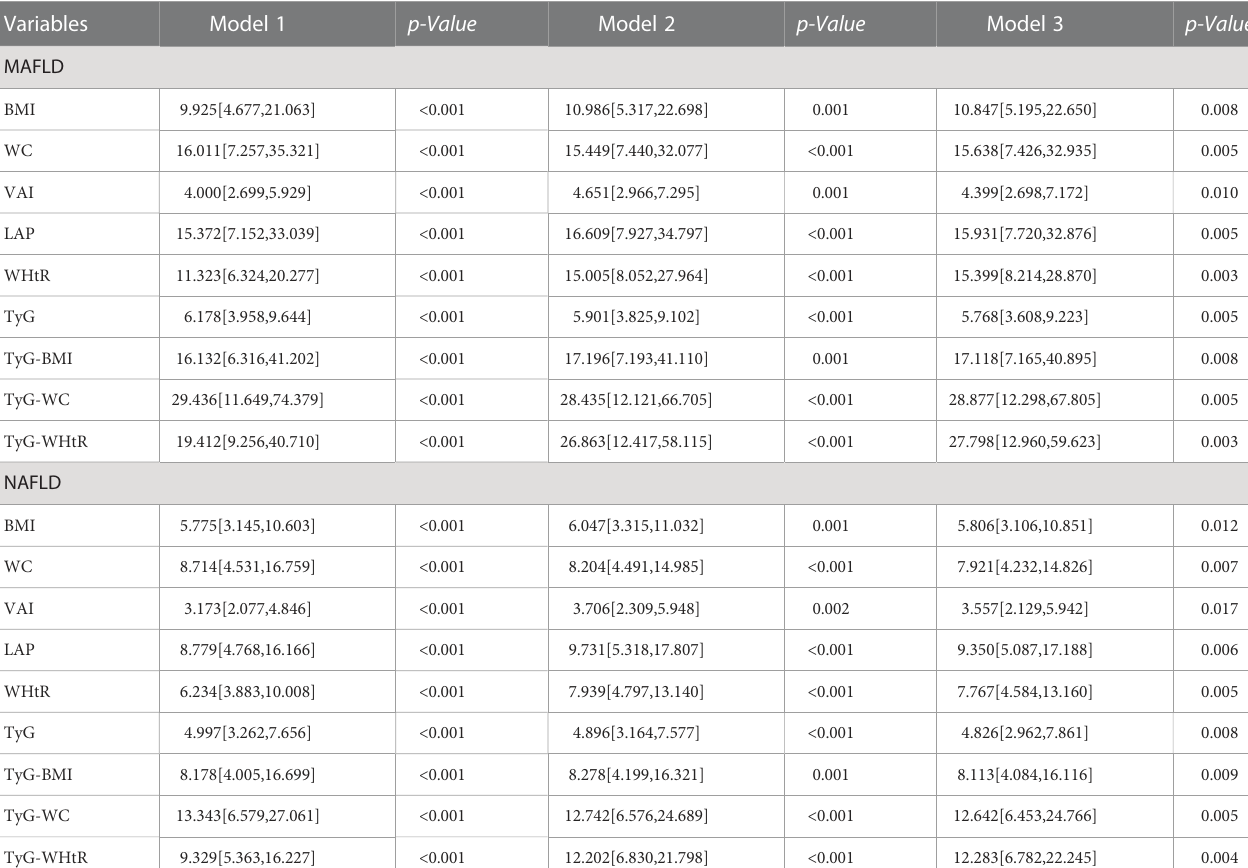
TABLE 2 Multi-variate adjusted ORs (95% CIs) of NAFLD and MAFLD in relation to quartile increment of nine predictive indexes among participants in NHANES 2017-2018.